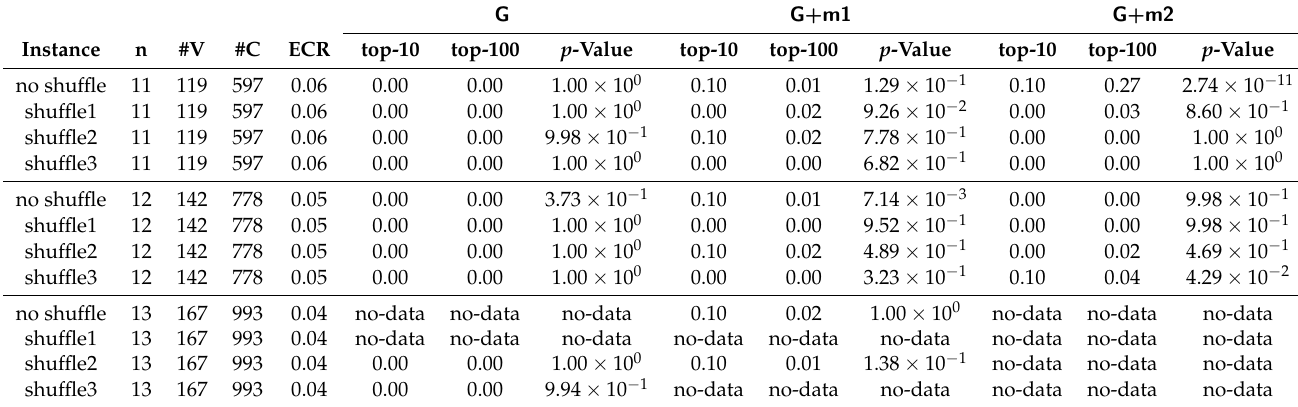
Table 7. DRUP analysis results of PHP instances with partial extension for